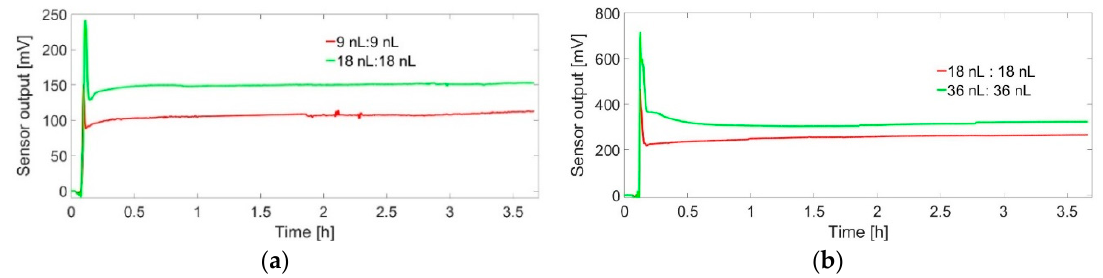
Figure 11. Sensor output for around 4 h at 130 °C operating temperature in continuous hydrogen flow at ( a ) 0.6% (ligand:nanoparticle = 9 nL:9 nL and 18 nL:18 nL) ( b ) 1.5% (ligand:nanoparticle = 18 nL:18 nL and 36 nL:36 nL); these curves are for Pt nanoparticles linked by PDA, influence of the amount of nanoparticles is higher for lower amount of nanoparticles that higher amount of nanoparticles.